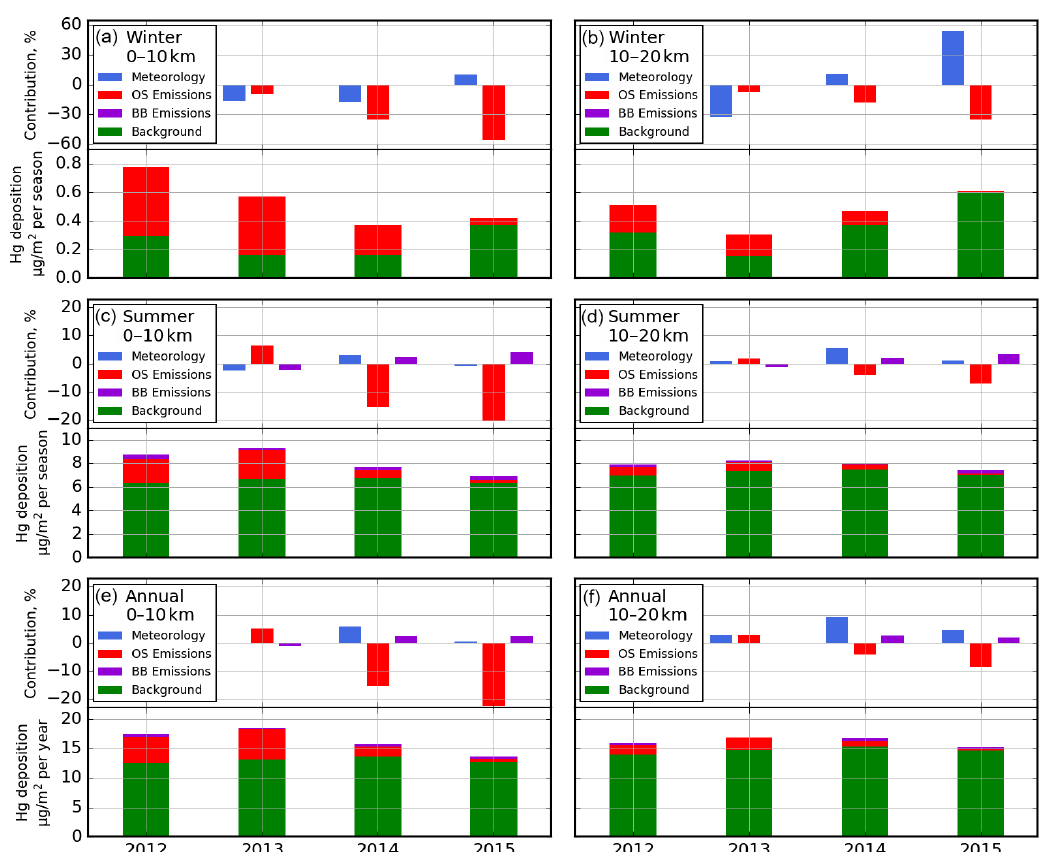
Figure 17. (a, b) December–February, (c, d) June–August and (e, f) yearly averaged source apportionment of total Hg depositions in 2012– 2015 and contributions of changes in meteorology, Athabasca oil sands emissions and biomass burning emissions (only in summer) (a, b) to the changes in total Hg depositions in 2013–2015 relative to 2012, within 10km (a, c, e) and 10–20km (b, d, f) of AR6.